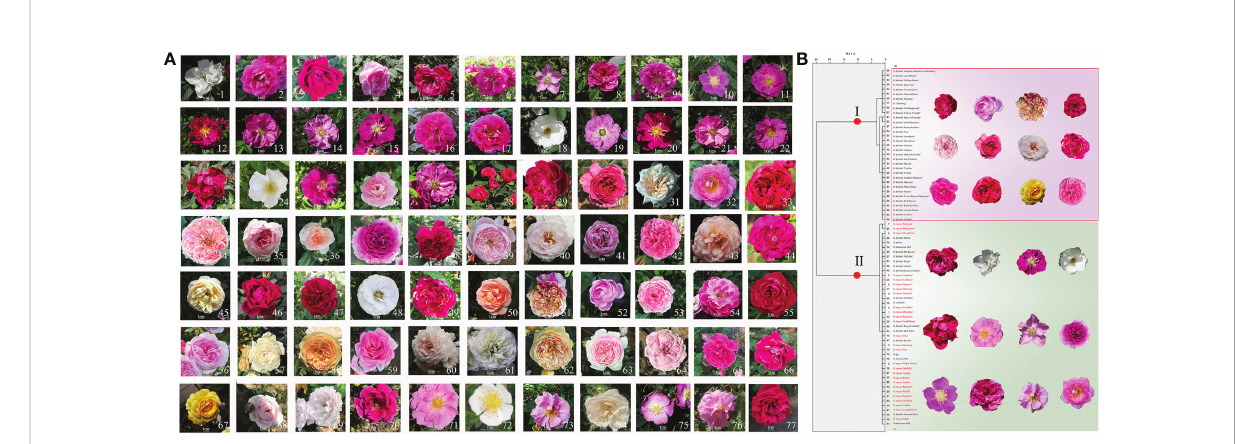
FIGURE 1 Study materials comprising 27 Rosa rugosa cultivars, 43 scented R. hybrida cultivars, and seven fragrant R. species, and cluster analysis of morphological characters in Rosa accessions. (A) 1 – 27, R. rugosa cultivars; 28 – 70, scented R. hybrida cultivars; 71, R. × damascena ; 72, R. spp.; 73, R. gallica ; 74, R. × damascena ‘ Alba ’ ; 75, R. davurica ; 76, R. centifolia ; 77, R. ‘ Dianhong ’ . (B) Dendrogram based on similarity in morphological traits. Rosa rugosa accessions are in red font, scented R. hybrida cultivars are in black font, and scented Rosa species are in blue font. The internal bar is 1